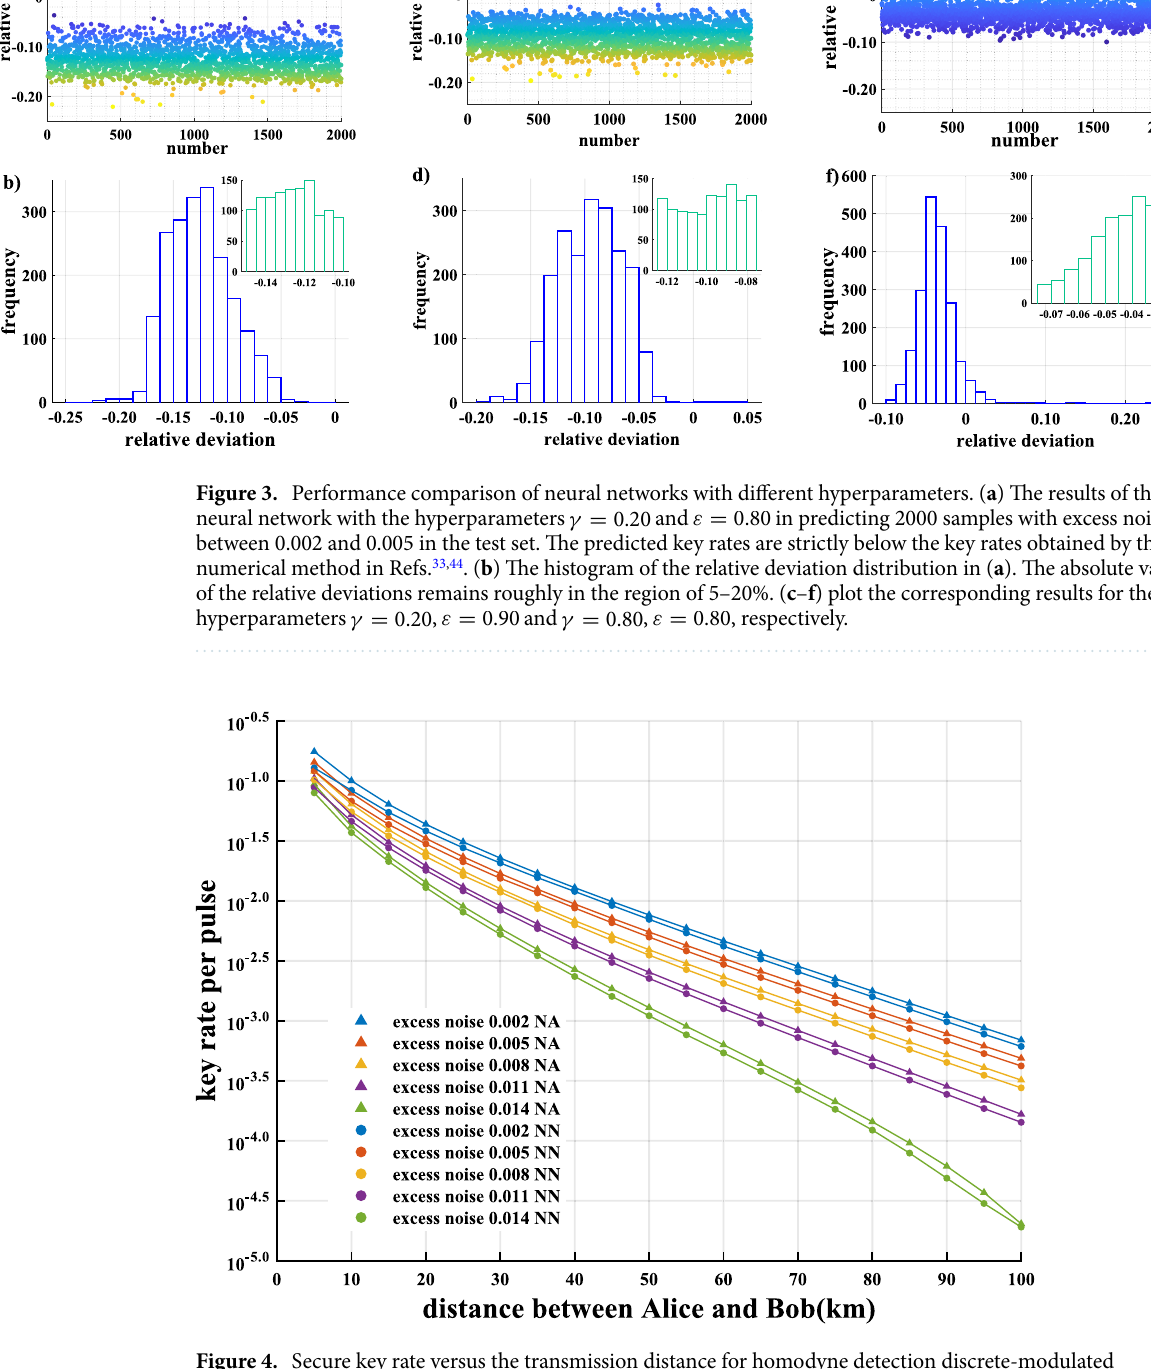
Figure 4. Secure key rate versus the transmission distance for homodyne detection discrete-modulated CV-QKD with excess noise ξ of 0.002, 0.004, 0.008, 0.011 and 0.014 using our neural network (circles) and the numerical method in Refs. 33,44 (triangles). The light intensity is chosen to be optimal in the interval [0.35, 0.6]. 0.02 L 10 0.95 . The neural network used for Tht transmission efficiency η . The reconciliation efficiency β − = = 0.80 . The cutoff photon number in the 0.20 and ε comparison is trained by setting the hyperparameters γ = = numerical method is set as